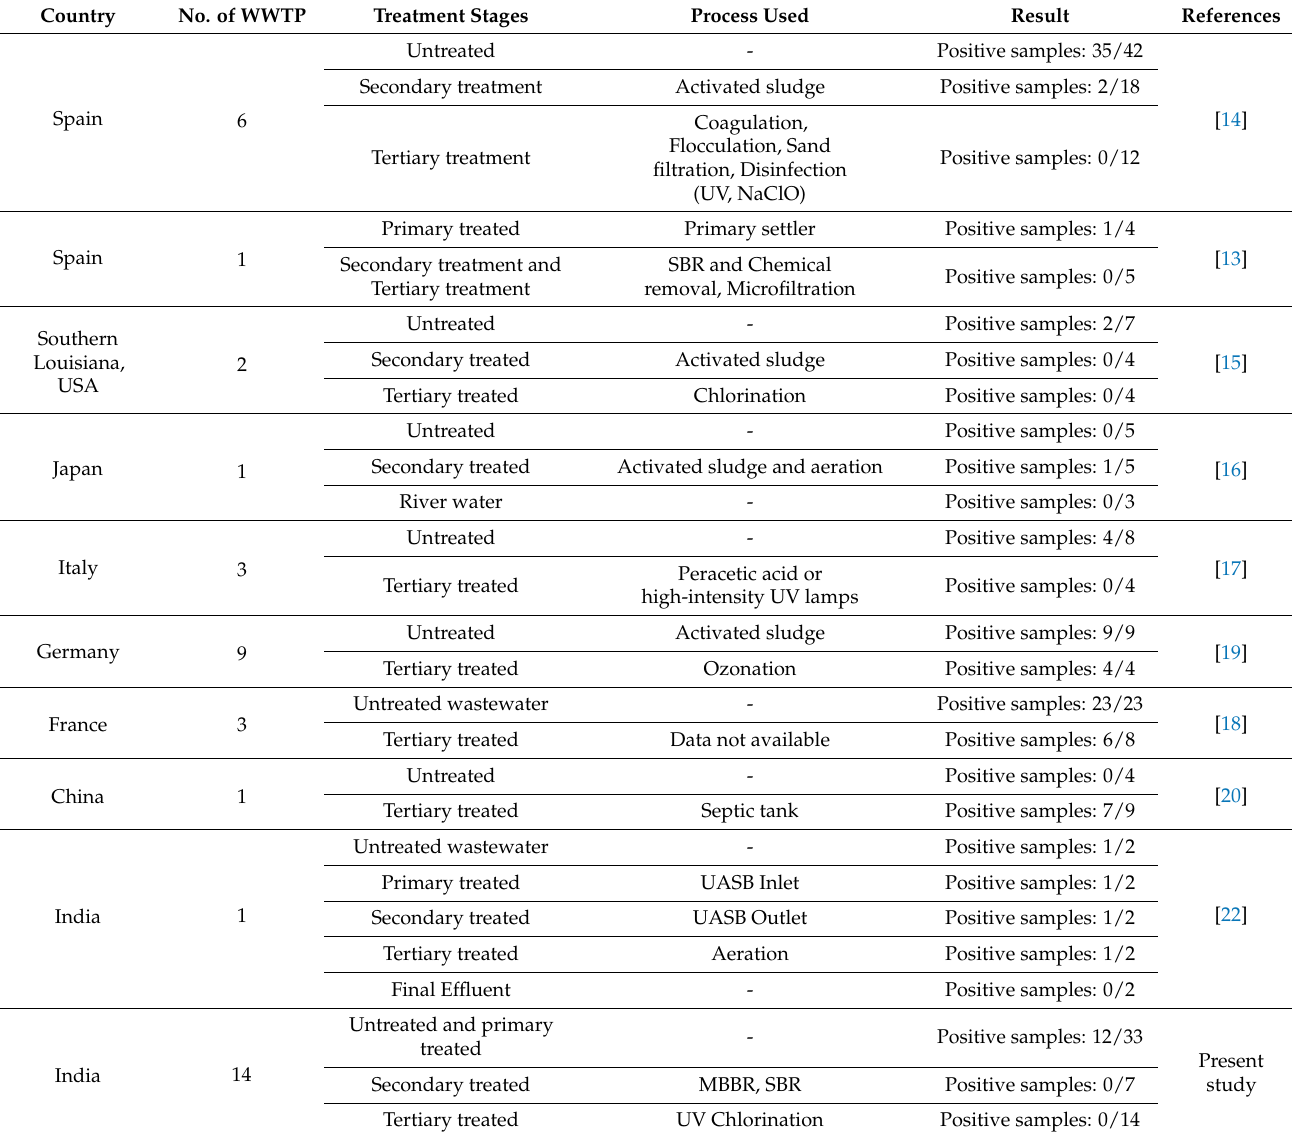
Table 1. Review on the efficacy of treatment processes in different stages of wastewater treatment plants (WWTPs) for the removal of SARS-CoV-2 RNA in different